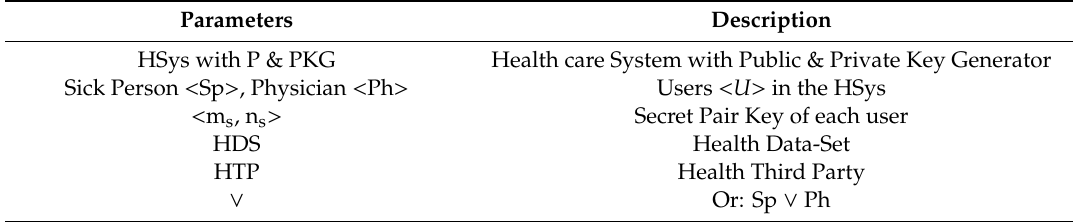
Table 1. Main parameters used in Algorithm